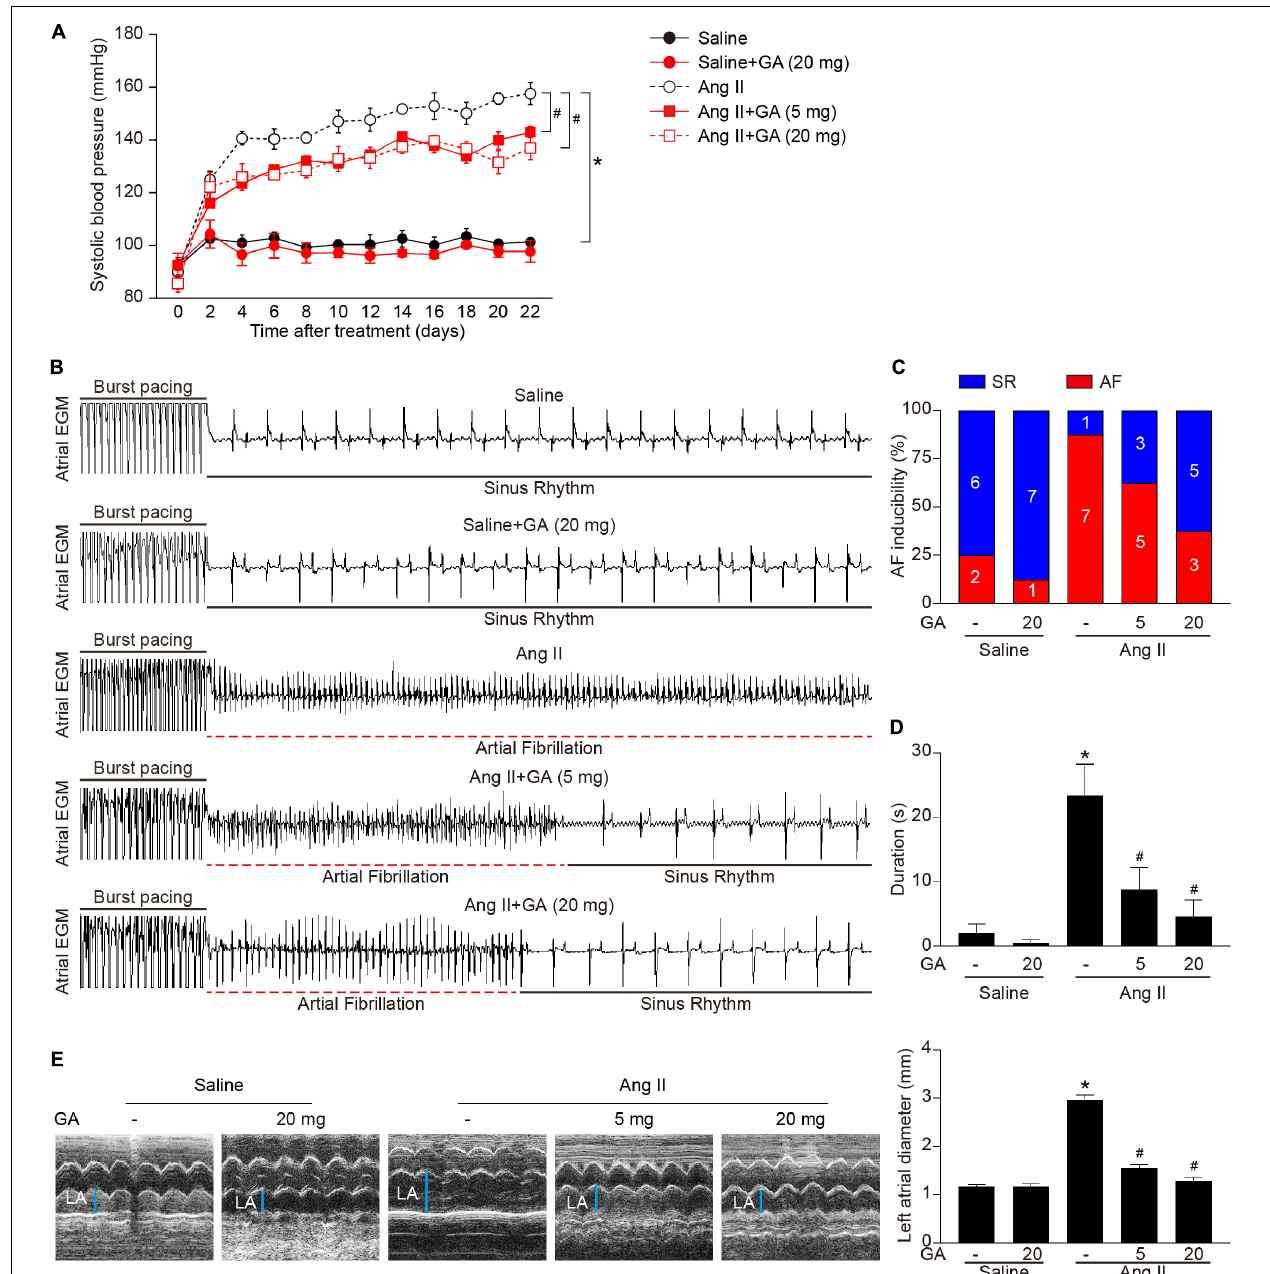
FIGURE 1 | Administration of GA attenuates Ang II-induced AF and atrial dilation. Mice were infused with Ang II (2000 ng kg - 1 min - 1 ) for 21 days. (A) Systolic blood pressure (SBP) was measured by the non-invasive tail-cuff method in vehicle or GA-treated mice before and after Ang II infusion. (B) Representative atrial electrogram recordings. Burst pacing is highlighted by solid underlines, while dashed underlines indicate AF. (C) Percentage of mice in which AF was successfully achieved in each group ( n = 8). (D) AF duration in mice with AF induction. (E) M-mode echocardiography of left atrium (LA) chamber (left), and quantification of LA diameter (right, n = 8). * P < 0.05 versus saline, # P < 0.05 versus Ang